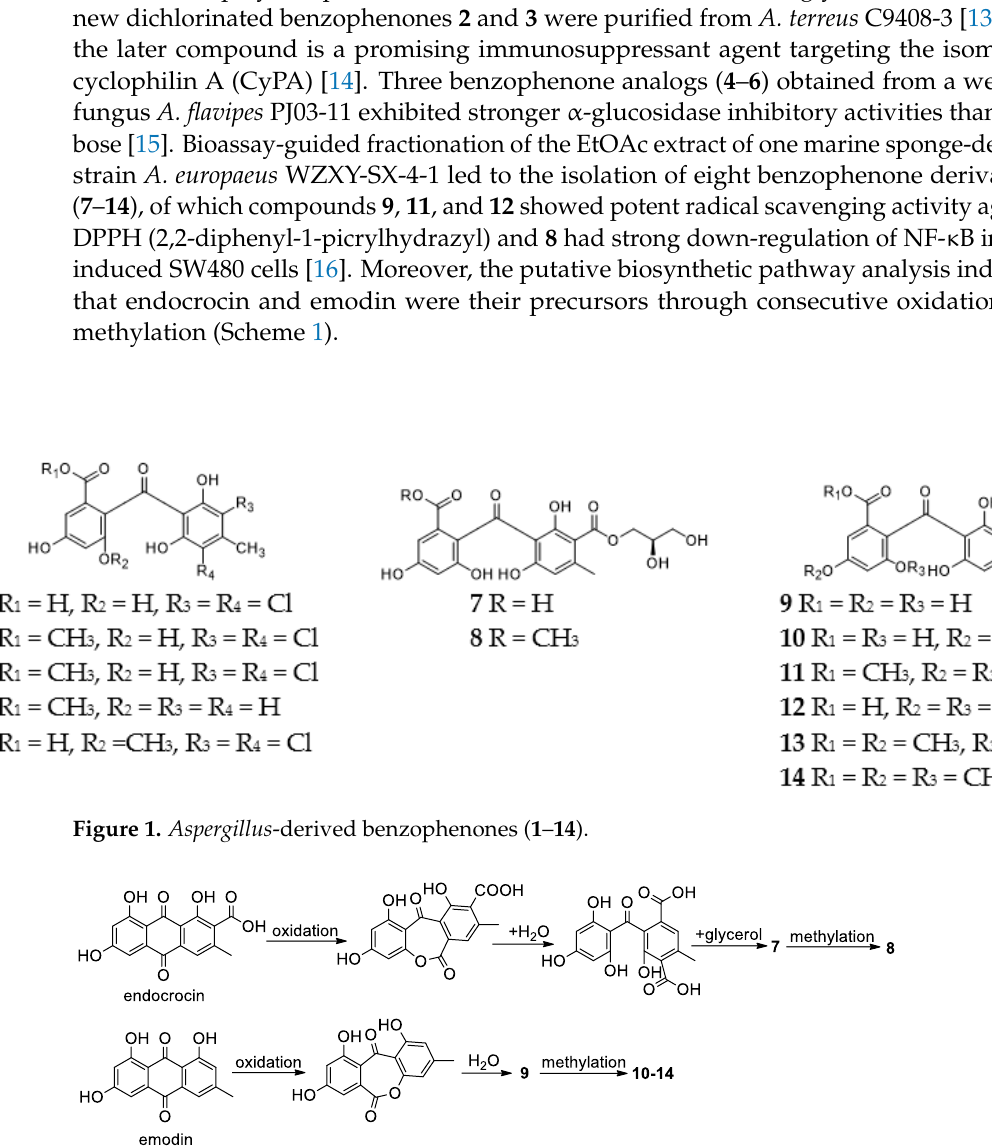
Scheme 1. Proposal biosynthetic pathways for compounds 7 – 14 .